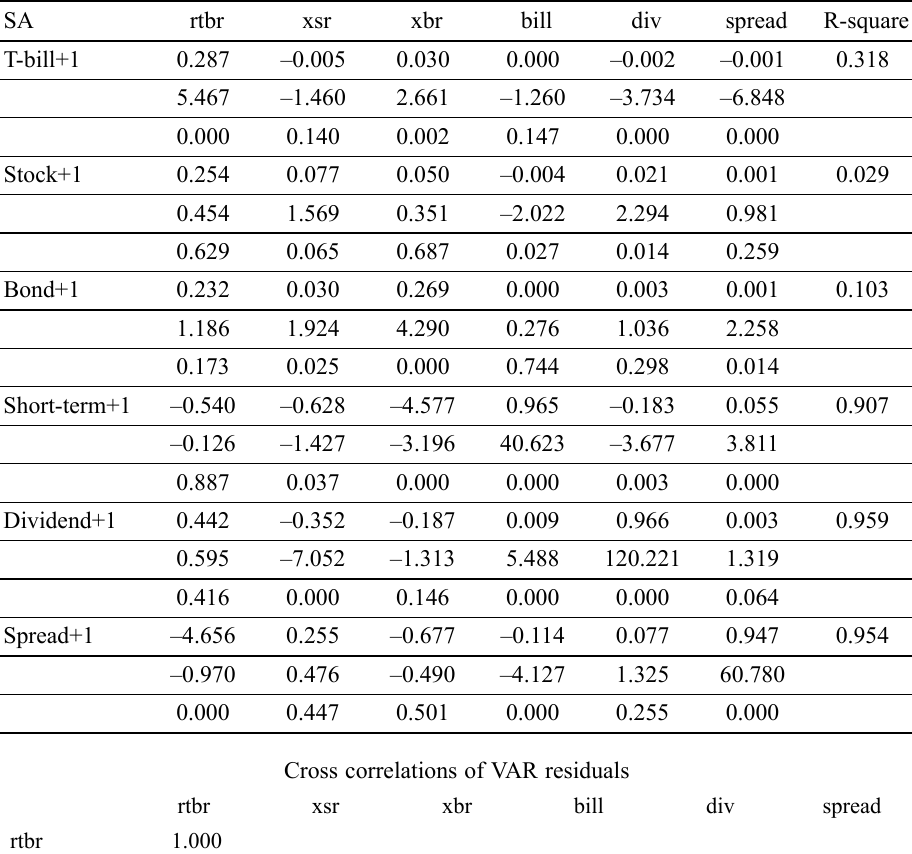
Table 7. An investor from SA who can invest in domestic assets, 1960:02–2010:09 VAR estimation results